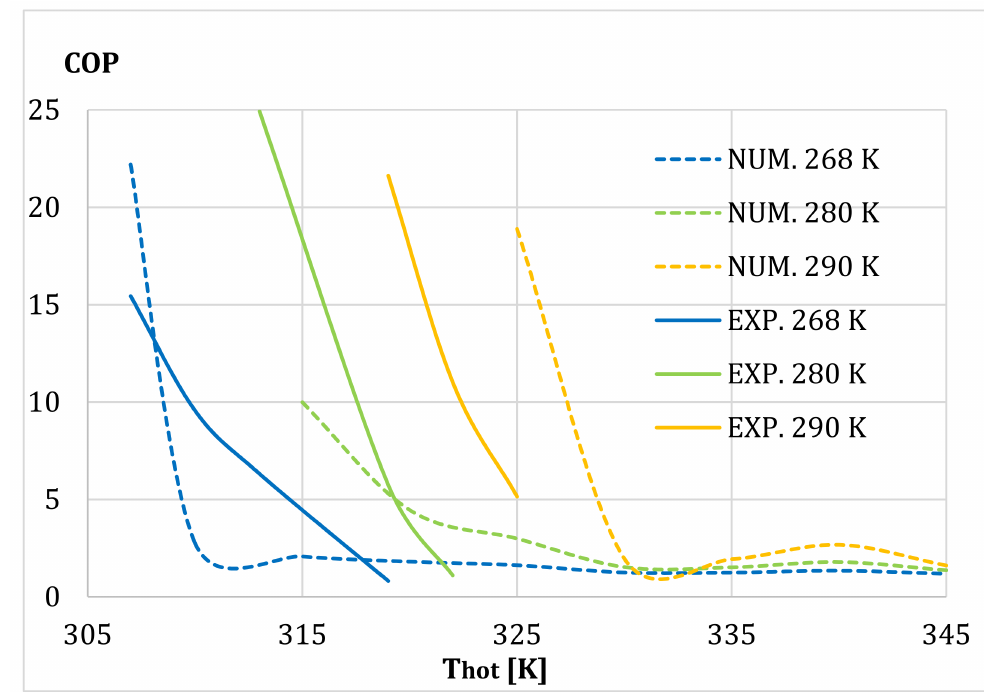
Figure 14. Comparison of the COP, as a function of T hot by varying the T cold , between numerical and experimental